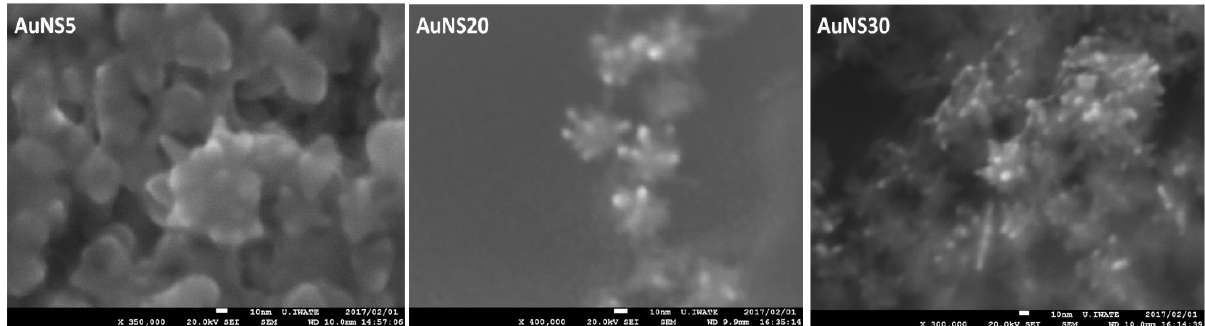
Fig. 1. SEM images of the AuNS5, AuNS20 and AuNS5 nanostars. A bar equals to 10 nm.